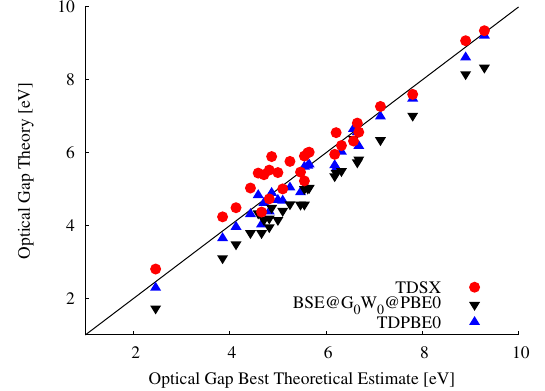
FIG. 3. The first lowest optical singlet excitations predicted by the TDSX compared to the revised best theoretical estimates (see text) of Thiel ’ s test set for 28 molecules. Values predicted for the same transitions by TDPBE0 (time-dependent density functional calculations with the PBE0 functional) and BSE @ G 0 W 0 @ PBE 0 (results from the solution of the BSE, starting from single-particle energies computed at the G 0 W 0 level of theory, with DFT results obtained with the PBE0 functional) are taken from Ref. [89].